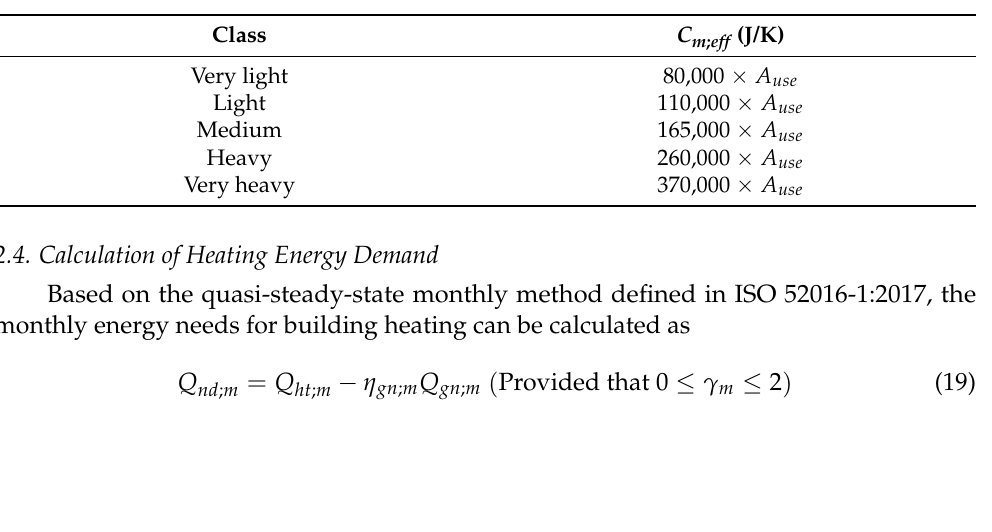
Table 2. Default values for internal effective heat